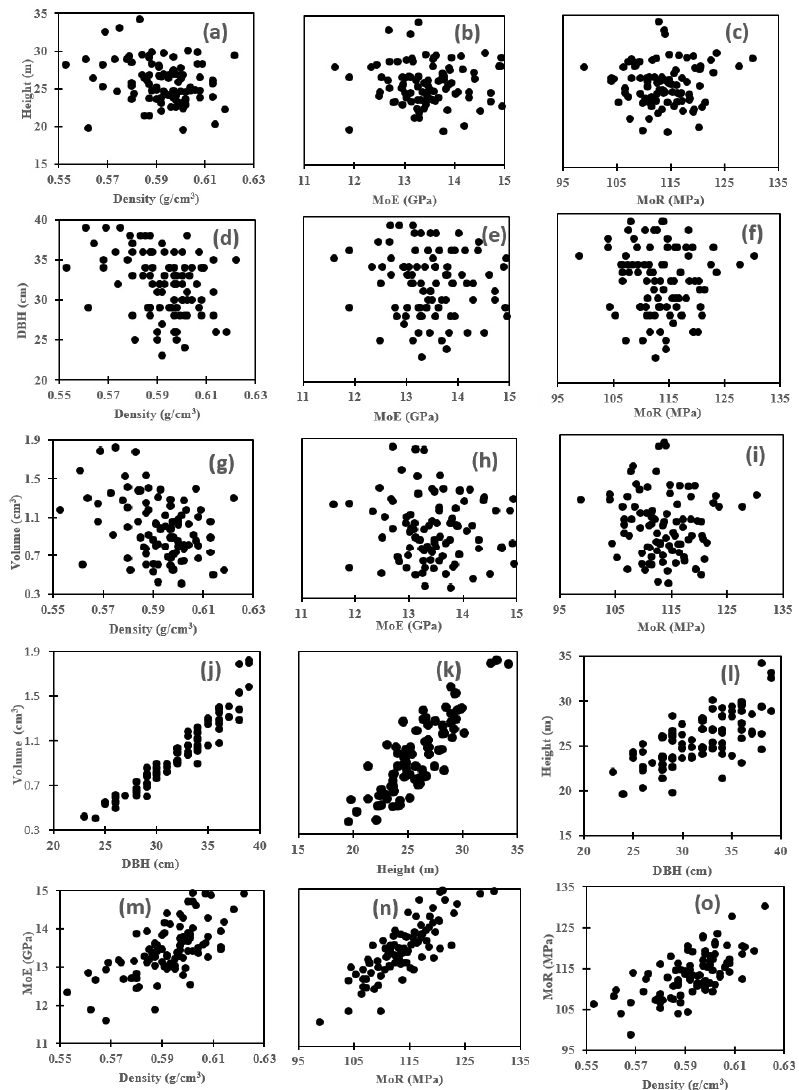
Figure 2. Phenotypic relationship between growth traits and wood properties ( a – i ); among growth traits ( j – l ); and among wood properties ( m – o ). traits ( j – l ); and among wood properties ( m – o